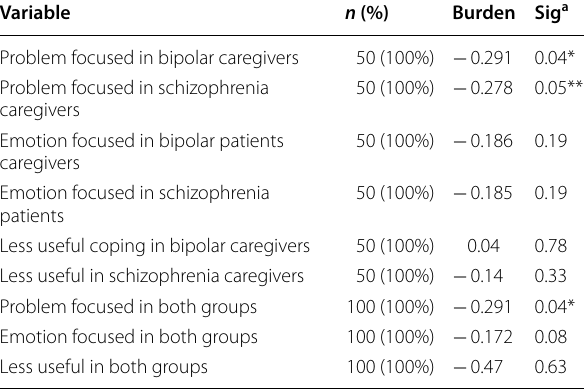
Table 3 Pearson correlation coefficient between burden and coping